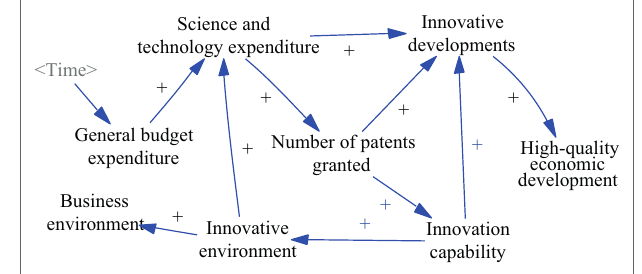
FIGURE 1 | Technology and innovative sub-system causality diagram.